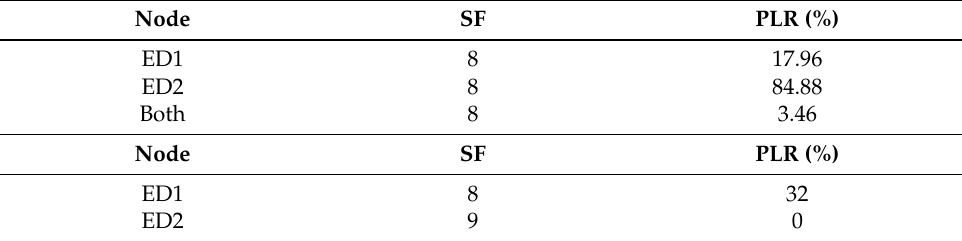
Table 3. Analysis of PLR between SF8 and SF9.